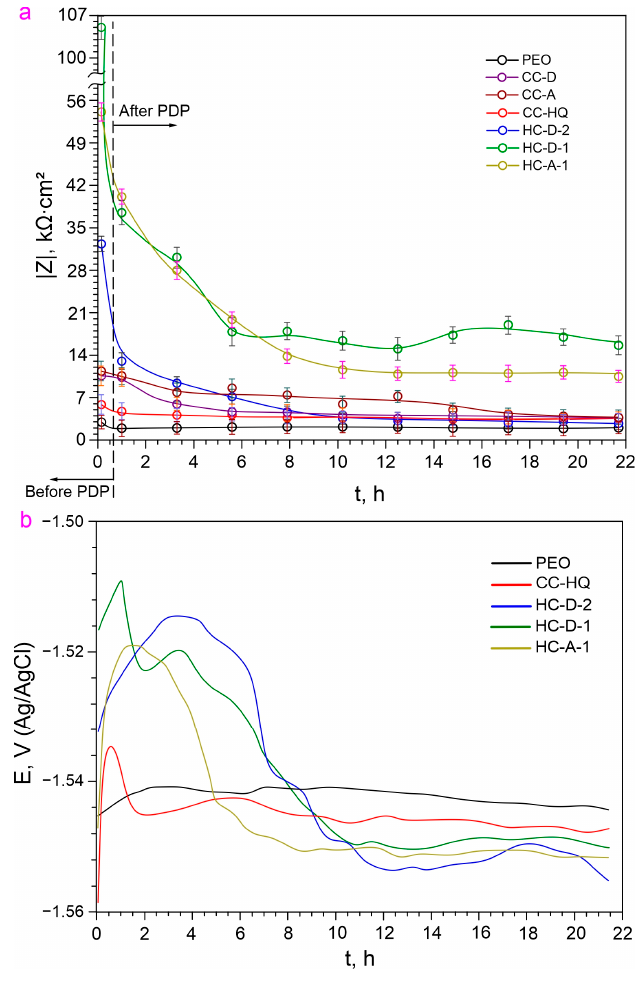
Figure 11. Evolution of impedance modulus measured at a low frequency ( a ) and open circuit potential ( b ) for studied samples during 22 h of exposure to 3.5 wt.% NaCl